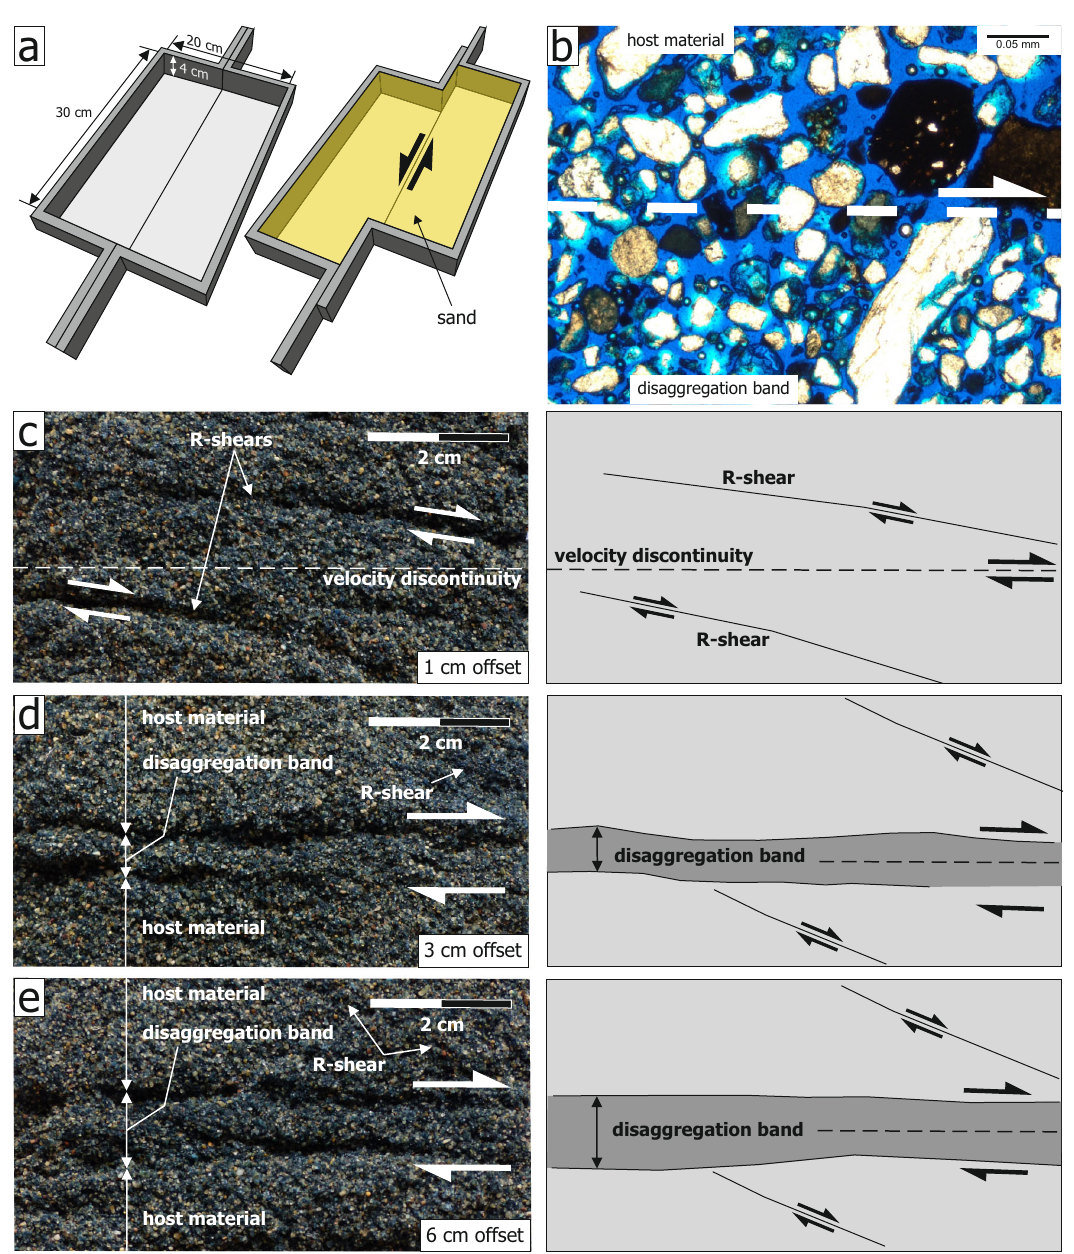
Fig. 4 Experimental results. a Experimental set-up of the shear box. The box is fi lled with natural material from the Freden outcrop. b Thin section of an experimental disaggregation band. Note the difference in porosity from the host material to the band. c After 1 cm of offset, Riedel shears (R-shears) evolve near to the velocity discontinuity. d After 3 cm offset, a central disaggregation band develops and the R-shears become inactive. e After 6 cm offset, the band becomes more distinct and grows thicker. The dark areas are grooves in the sample that result from the hindered resin percolation due to changes in